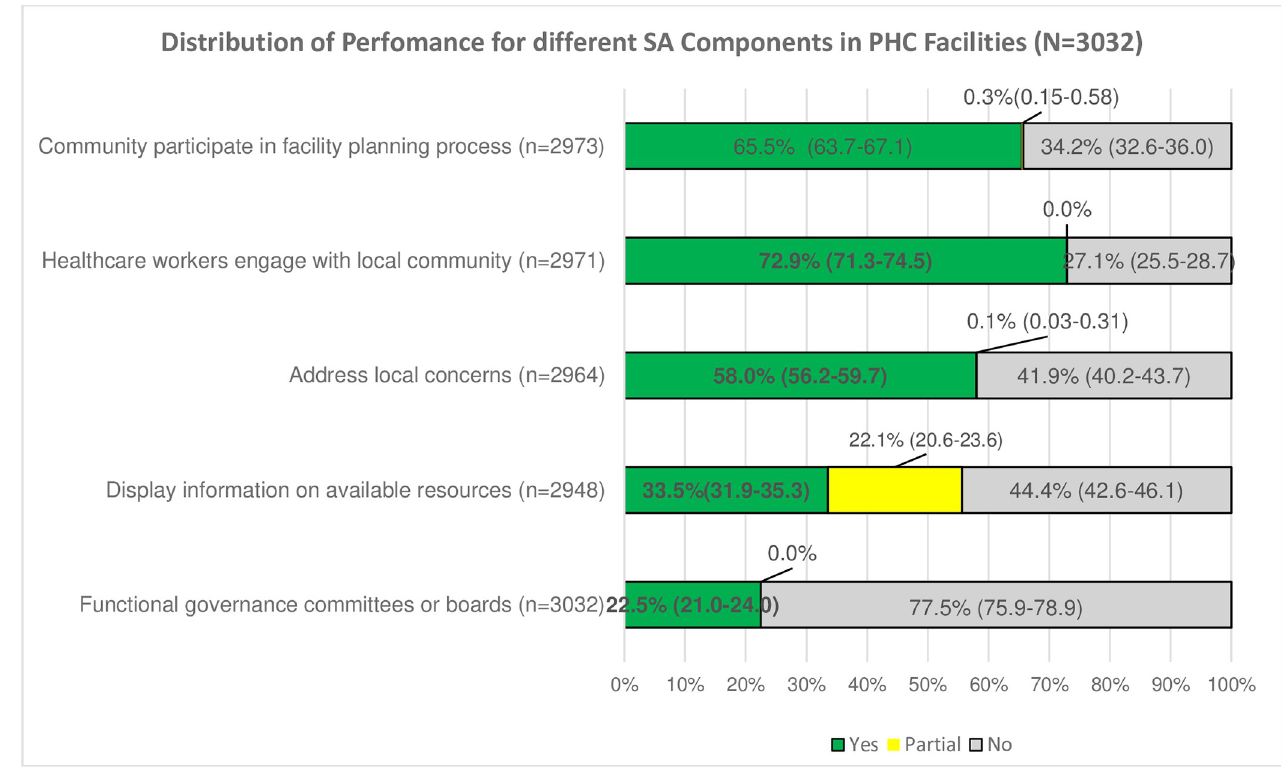
Fig 2. The distribution of performance for different social accountability components (N = 3032).